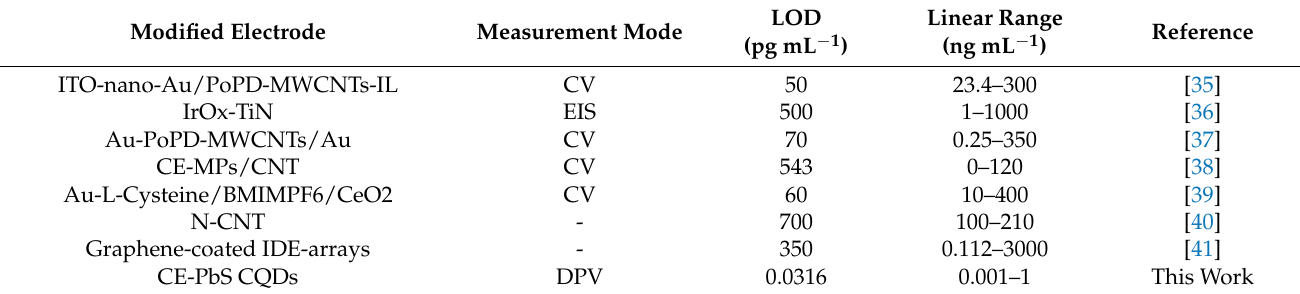
Figure 5. The sensing performance of the PbS CQD-modified electrode for MPO testing. ( a ) DPV curves with the increased antigen concentrations (1 pg mL − 1 to 100 ng mL − 1 ); ( b ) Antigen concentration-dependent response curve using a linear fit. Table 1. Parameters comparison for the detection of MPO biomarkers.